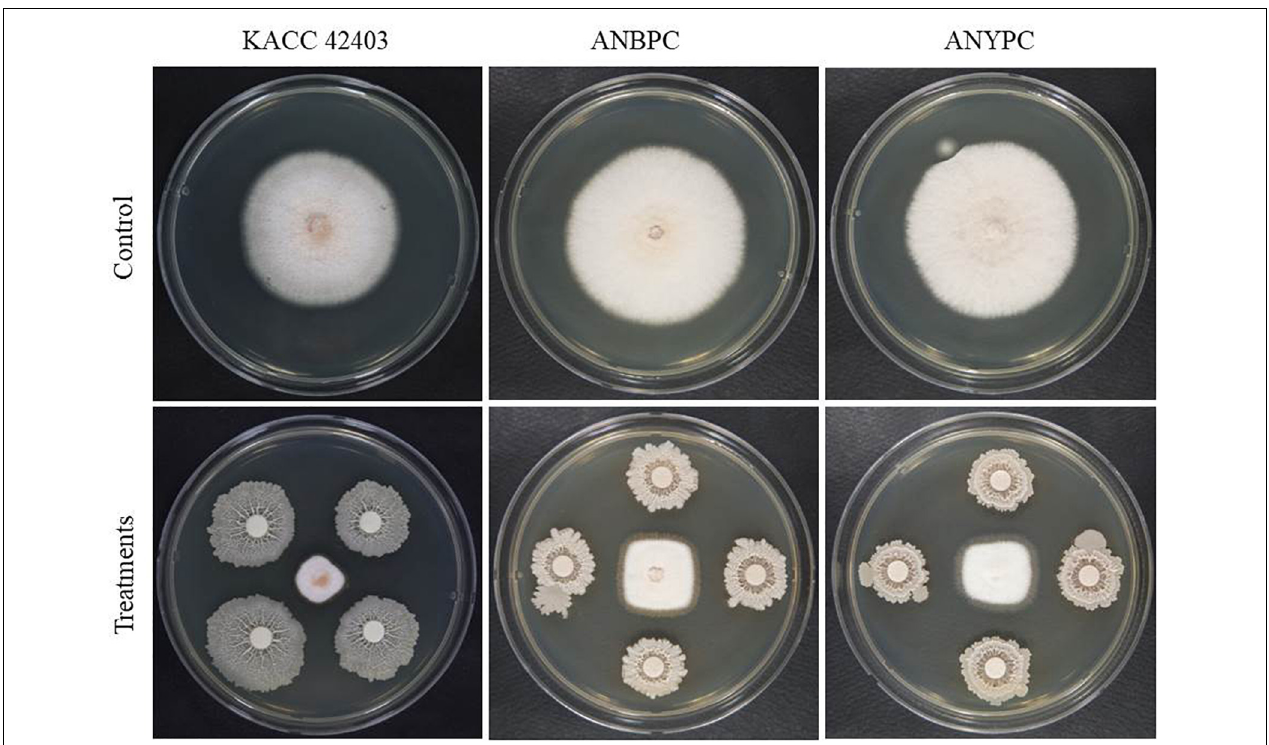
FIGURE 1 | In vitro antagonistic activity of Bacillus tequilensis GYUN-300 on the inhibition of Colletotrichum acutatum fungal stains in comparison with the non-treated control. Mycelial growth of fungal pathogens on potatoes dextrose agar plates was recorded 7 days after incubation at 25 ◦ C. The experiment was repeated at least once, with each treatment carried out in